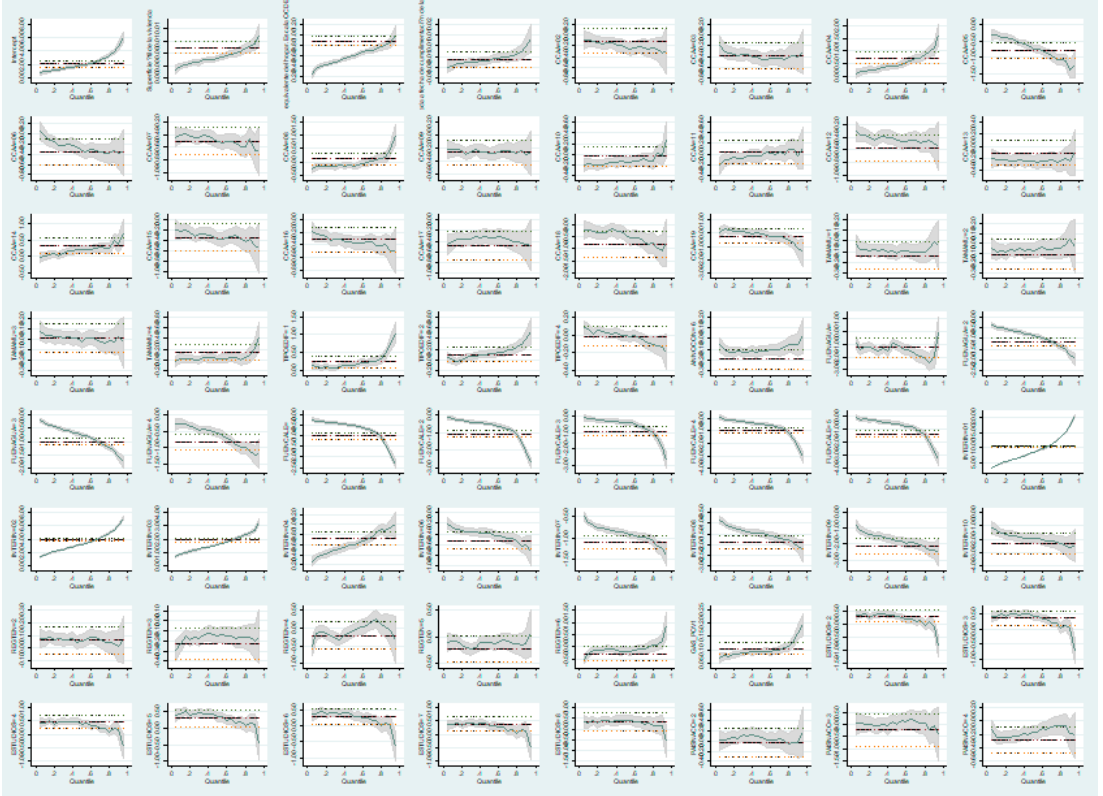
Figure A1. Electricity poverty. Quantile coefficients.